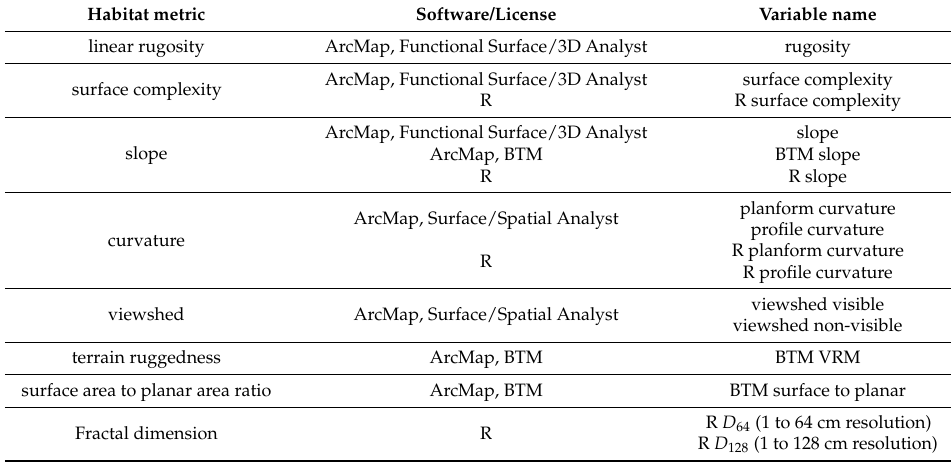
Table 2. List of habitat metrics obtained and the variable names used in the present study. Software and a toolset/license for ArcMap used for each metric are also